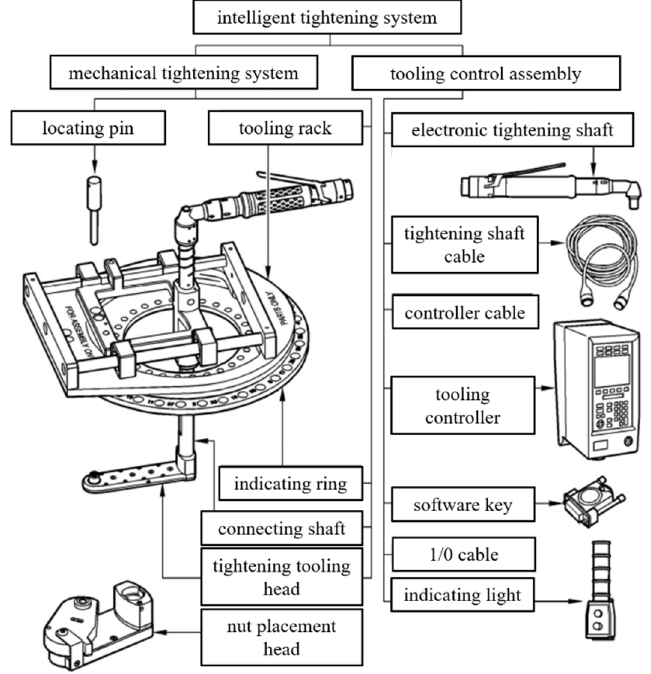
Figure 22. Semi-automatic tightening equipment used in the V2500 aeroengine in the United States [95].